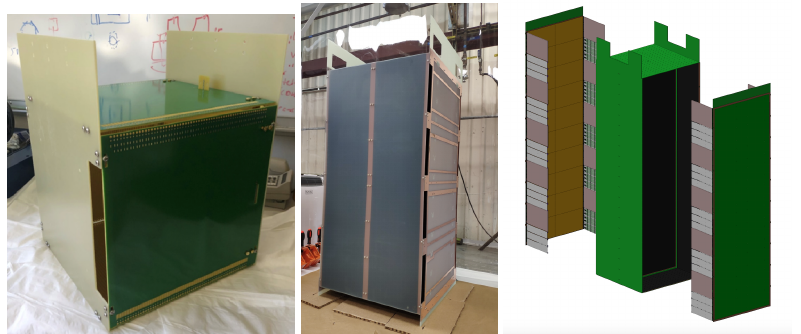
Figure 14. ( Left ) The SingleCube LArTPC designed to test a single integrated large-format charge and light readout element. ( Center ) The mechanical assembly of the first module (Module 0) of the ArgonCube 2 2 Demonstrator, including the cathode, field cage, and anode support panels. The × module is a sub-scale prototype of the ND LArTPC module, at 60% drift length and 40% module height. ( Right ) The engineering model of the full-scale ND LArTPC module (1 m by 1 m footprint and 3.5 m height), shown with the anode panels detached from the field cage. The pixelated anode tiles (gold rectangles) provide true 3D imaging, while the dielectric light traps (pink and while rectangles) provide high-efficiency scintillation light